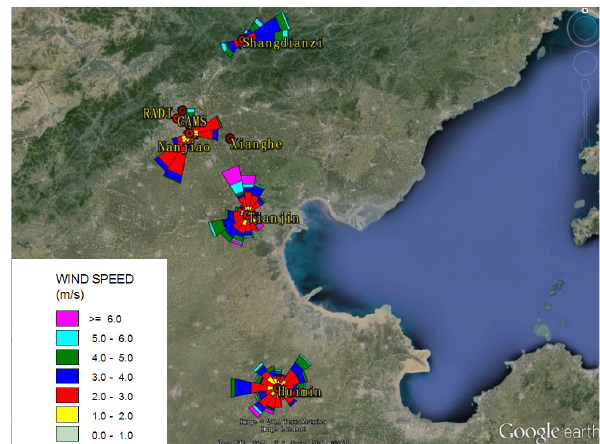
Fig. 1. Distribution of the seven sun photometer sites in North China Plain. Wind rose maps were plotted at Shangdianzi, Nanjiao, Tian- jin, and Huimin, using observation data on the hourly meteorologi- cal wind speed and